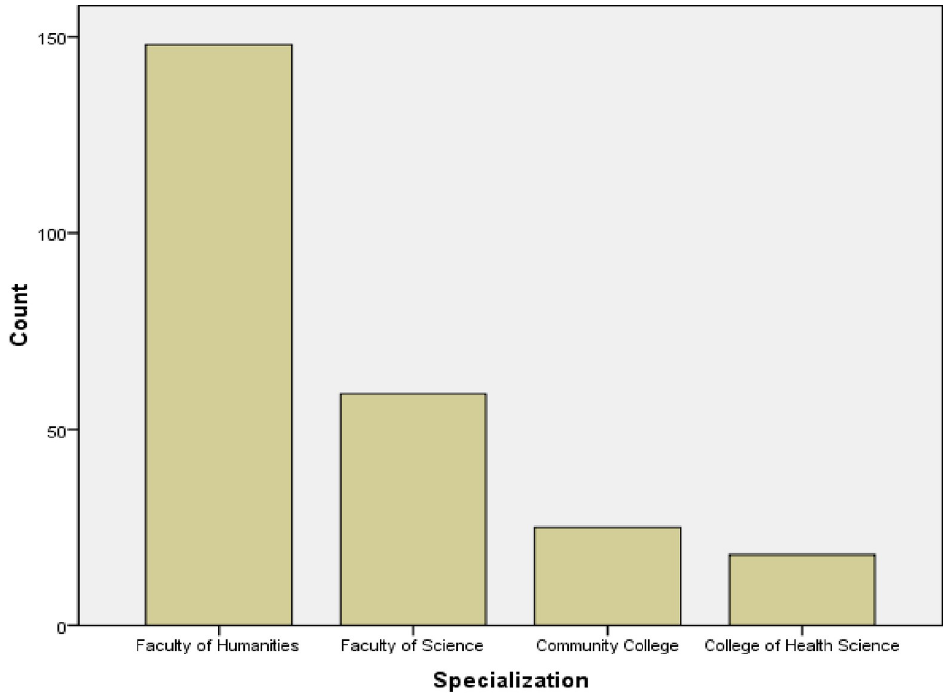
Fig 1. Sociodemographical features showing specialization of